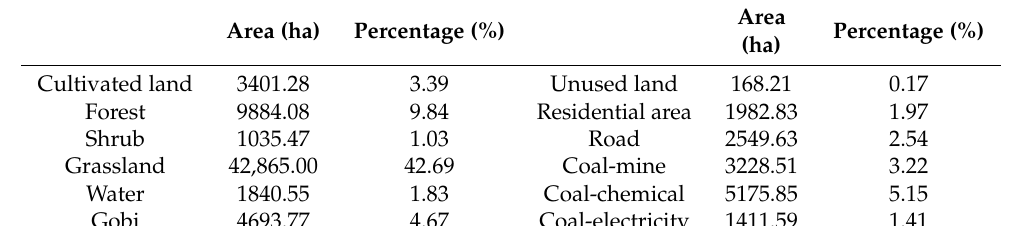
Table 4. Statistic of land-use/land-cover (LULC) in 2019.